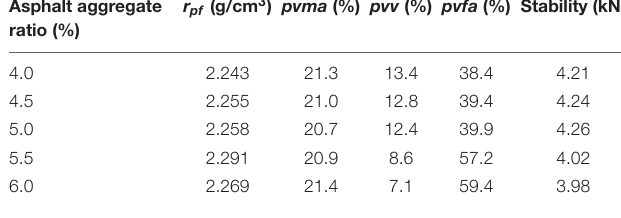
TABLE 7 | Volume parameters and mechanical index results of initially formed